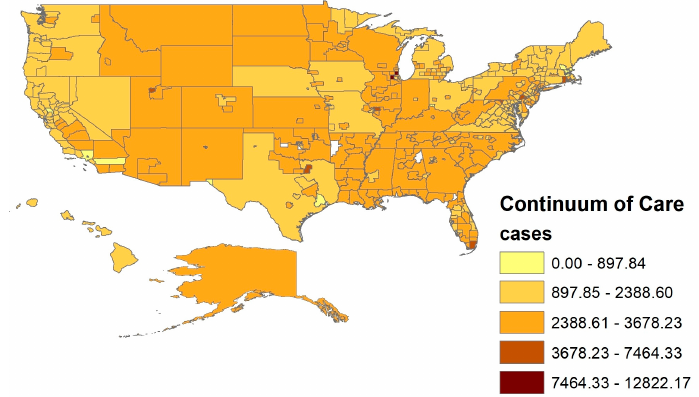
Figure 1. COVID-19 Case Rates by Continuum of Care.